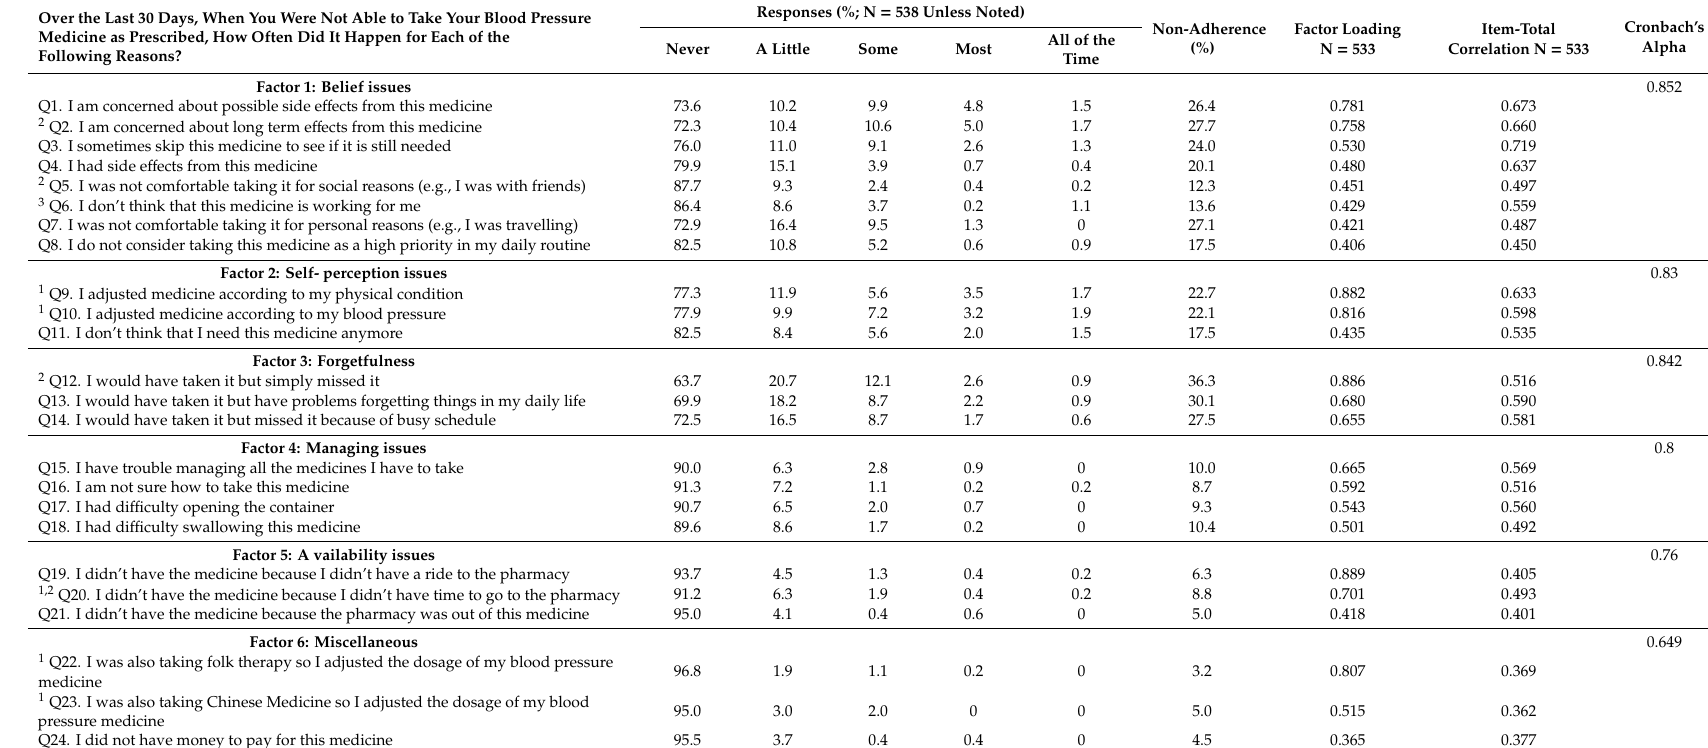
Table 4. Psychometric properties of the ChMAR-Scale 1